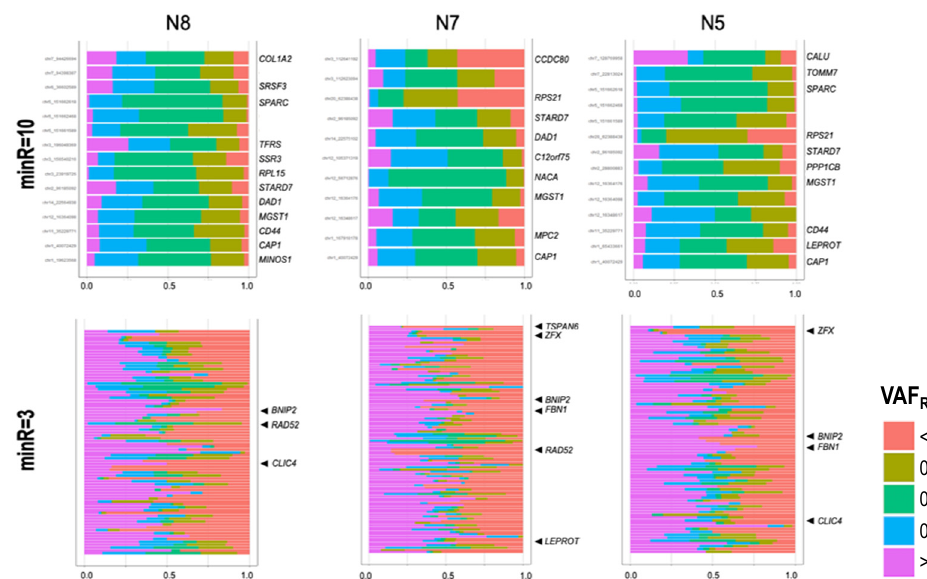
Figure 6. scVAF RNA distribution at positions covered by a minimum of 10 sequencing reads (top), and three sequencing reads (bottom), across more than 1500 cells for genes reported by Borel et al. [9]. For the positions with minR = 10, no RME was suggested by the scVAF RNA distribution for autosomal genes (i.e., for the majority of the estimations scVAF RNA values were between 0.2 and 0.8), while positions covered with minR = 3 showed frequent monoallelic signals (scVAF RNA > 0.8 or scVAF RNA < 0.2). As expected, chrX shows strong RME patterns (see gene TSPAN6 ).